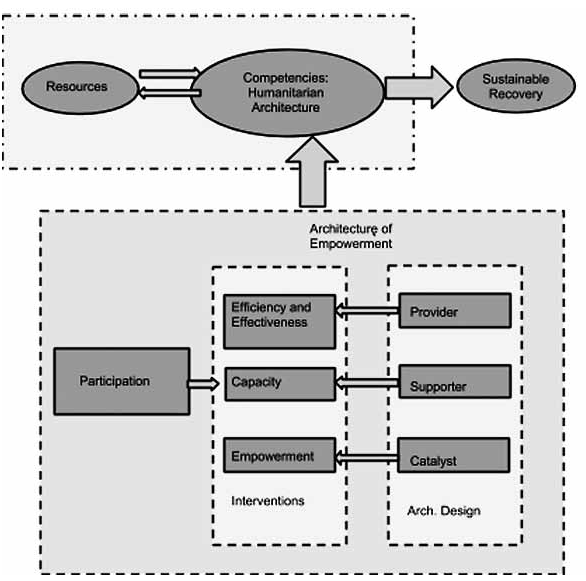
fig. 3. framework of architecture roles in post-disaster psychosocial interventions